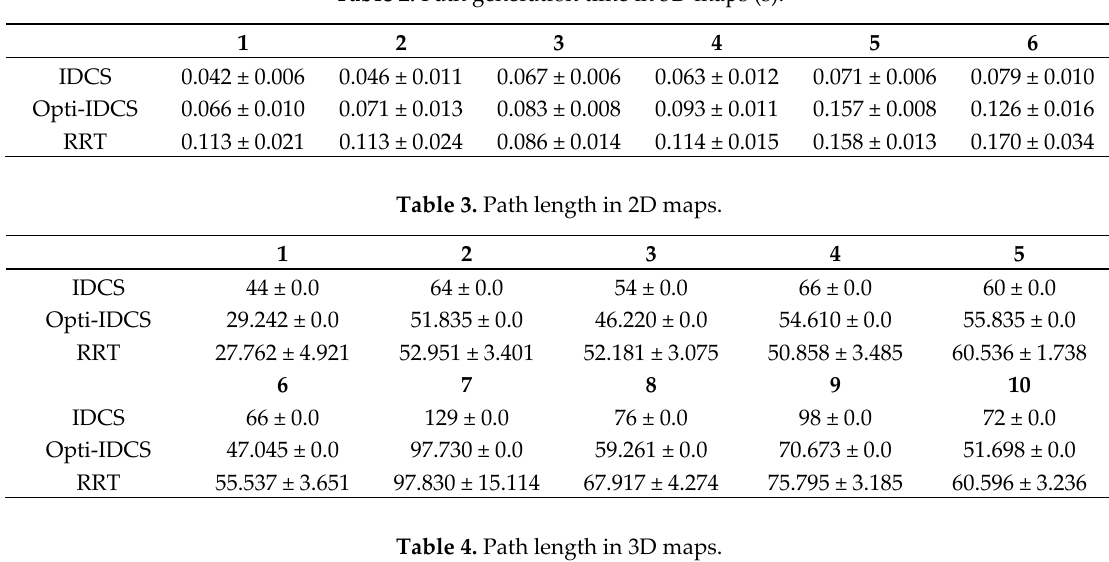
Table 2. Path generation time in 3D maps (s).